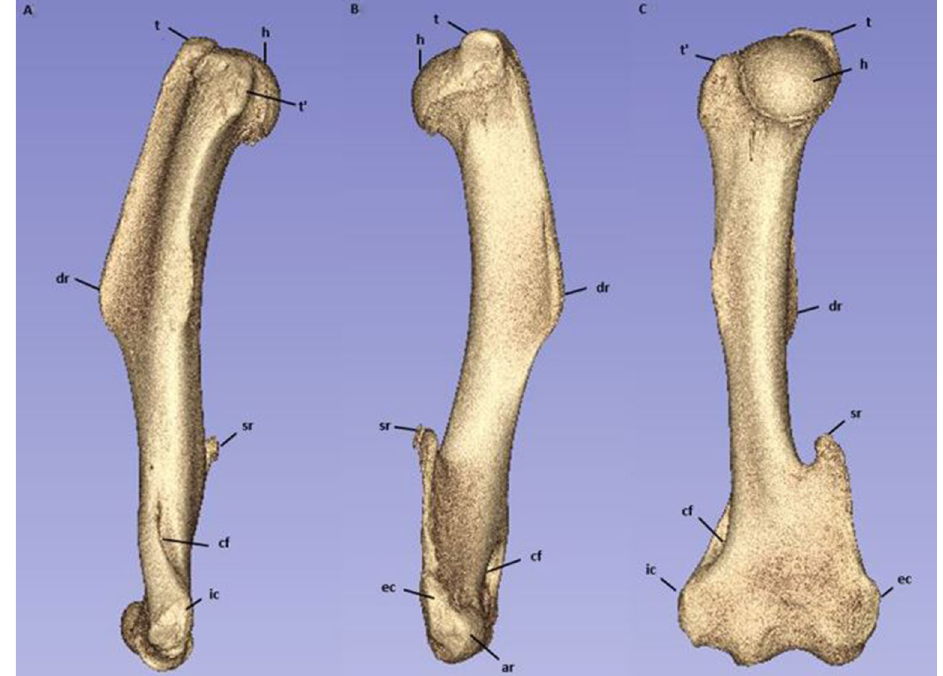
Figure 1. 3D reconstruction of the koala humerus from micro-CT scan using Slicer version 4.10.2. Inluding ( A ) medial view with left of the image being cranial, ( B ) lateral view with the right of the image being cranial, and ( C ) Caudal view with left of the image being medial. Identifying landmarks are also identified. Where h = humeral head; t = greater tuberosity; t’ = lesser tuberosity; dr = deltoid ridge; sr = supinator ridge; cf = supracondylar foramen; ec = external epicondyle; ic = internal epicondyle; ar = articular surface (radius); au = articular surface